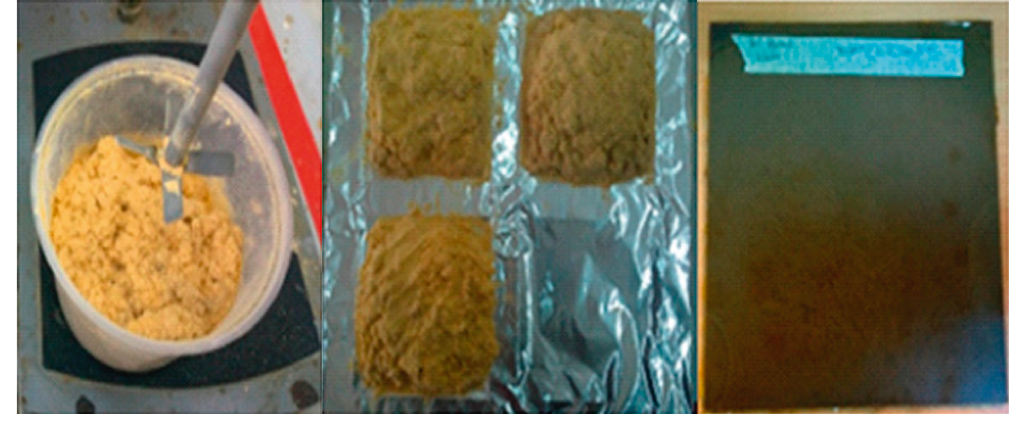
Figure 2: Fabrication procedure.